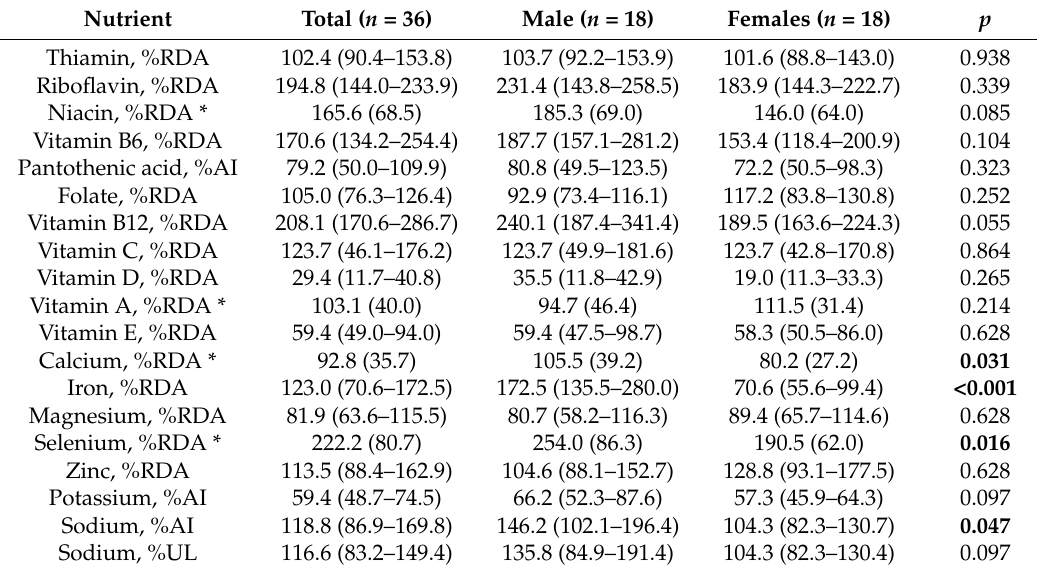
Table 3. Micronutrient intakes from food